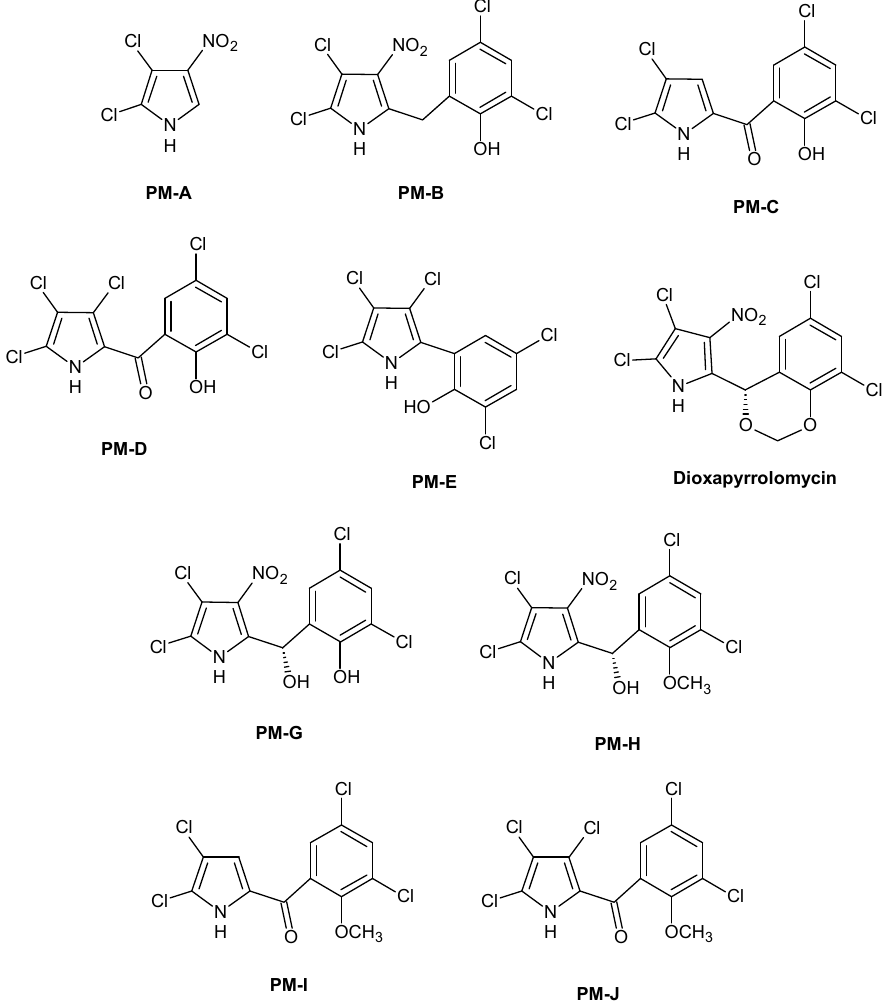
Figure 3. Structures of pyrrolomycins A, B, C, D, E, G, H, I, J and dioxapyrrolomycin.